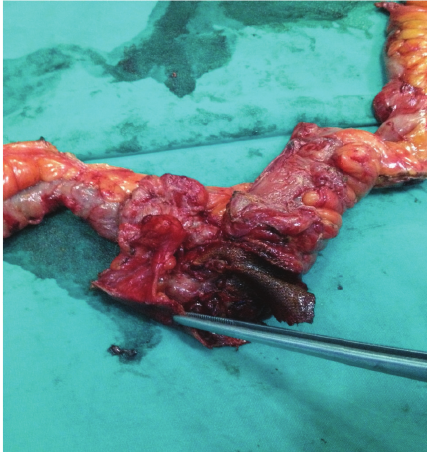
Figure 2: The pathological specimen and mesh migration to the intestine.